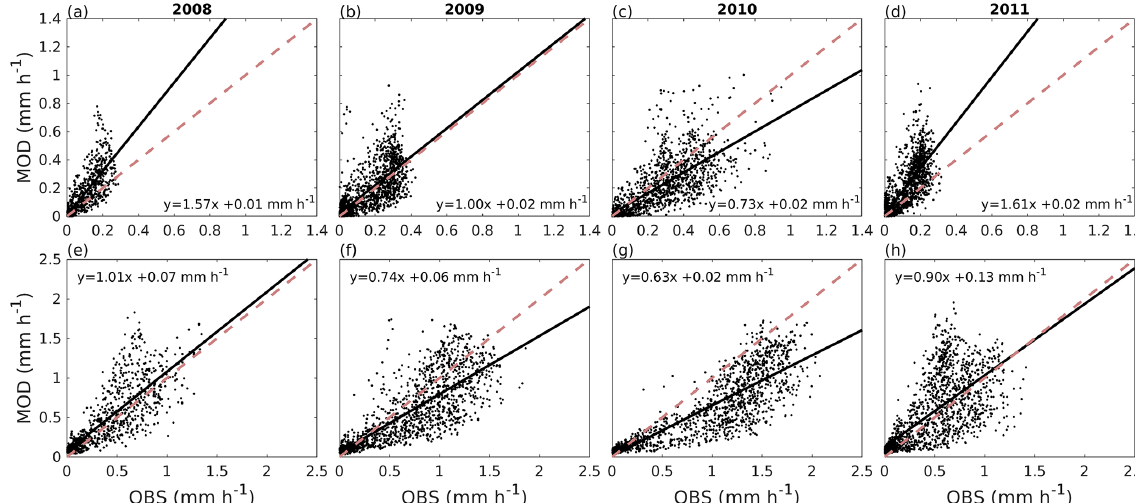
Figure 5. Correlation between hourly values of modelled transpiration (MOD) and transpiration estimated from sap flow measurements (OBS) from June to August for the Tilia site (a–d) and the Alnus site (e–h) for each year during the period 2008–2011. The dashed red line is the 1 : 1 line, and the solid black line represents the linear fit.